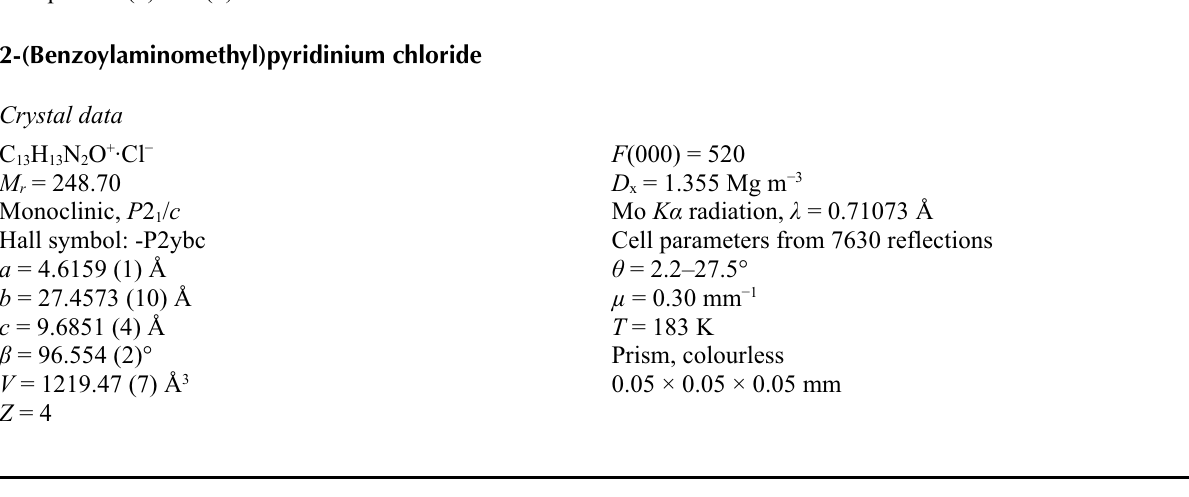
Compounds (1) and